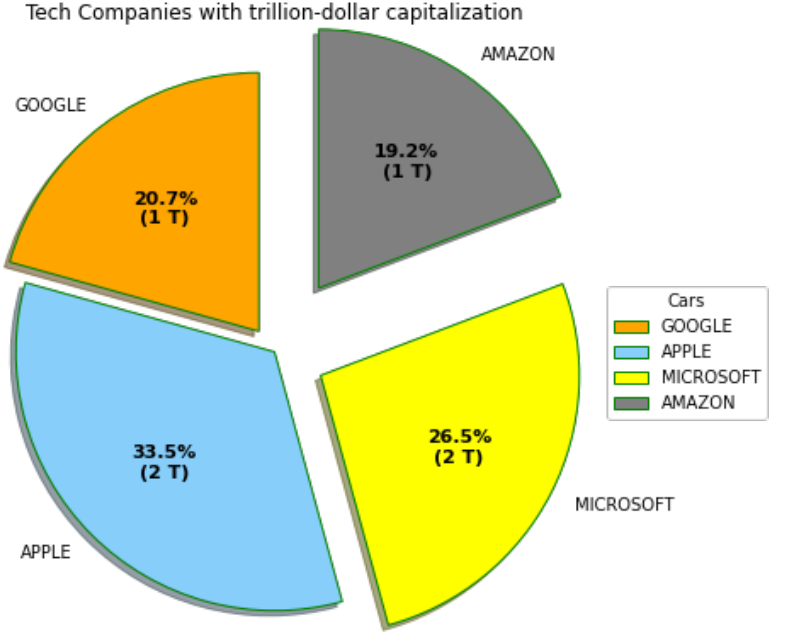
Figure 3. Tech companies with trillion-dollar capitalisation.